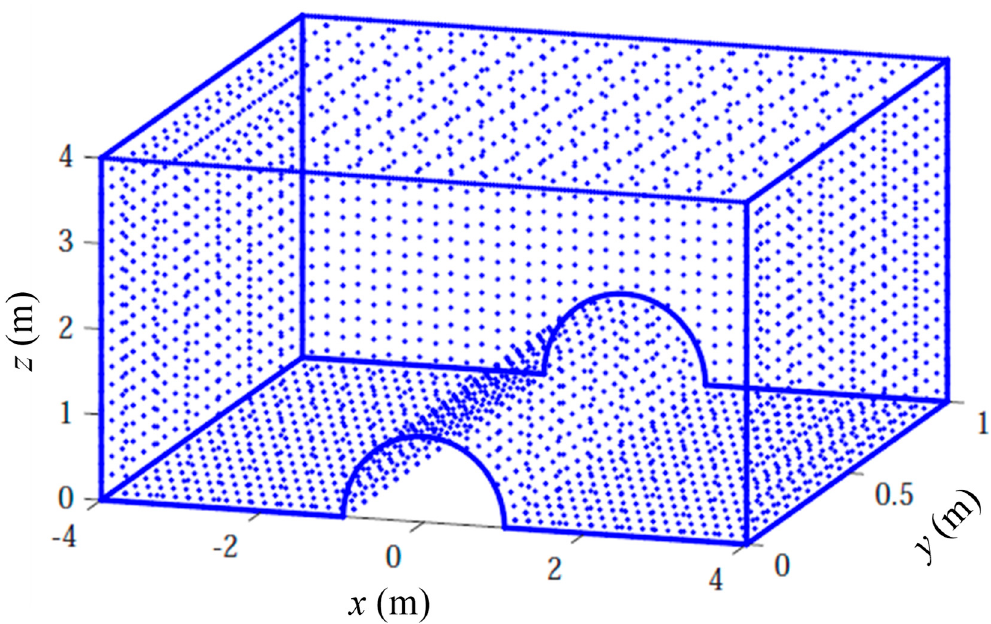
Figure 9. Collocation points on the three-dimensional boundary.